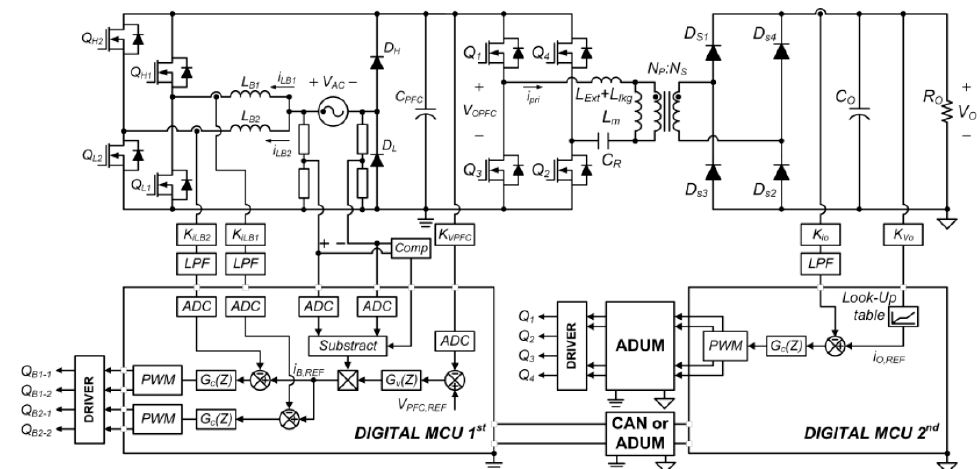
Figure 8. Circuit diagram and control block diagram of the prototype with two digital microcontroller (MCU).